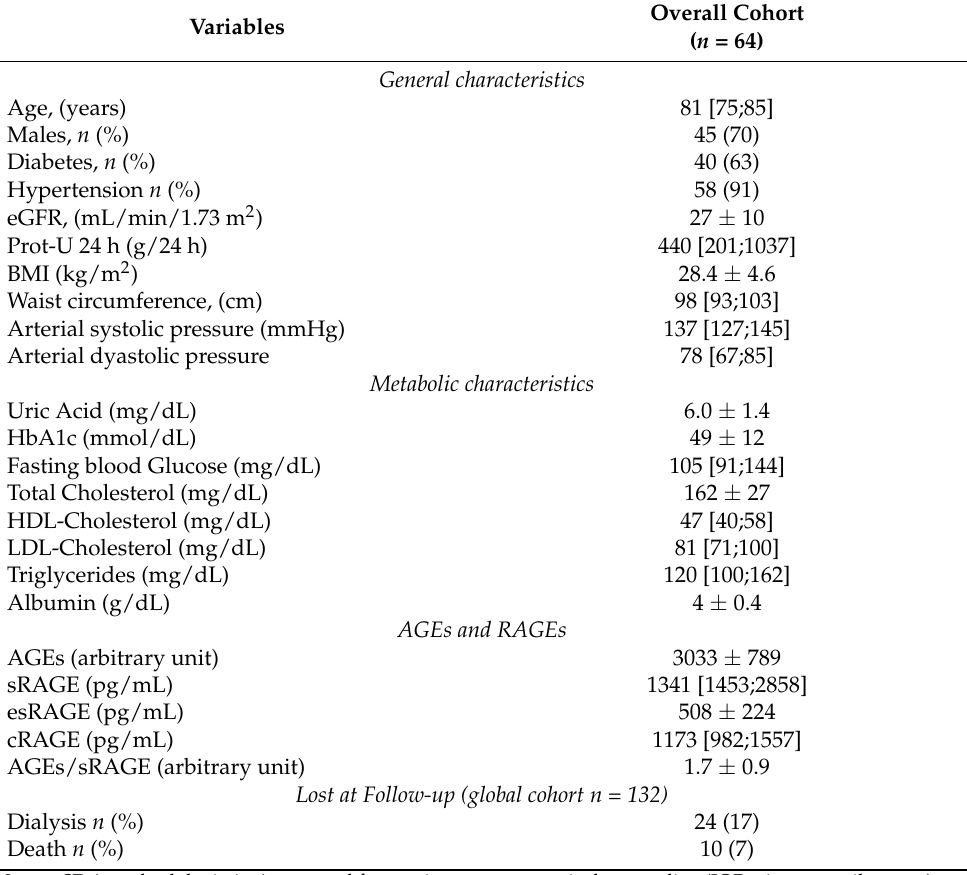
Table 1. Patients’ cohort